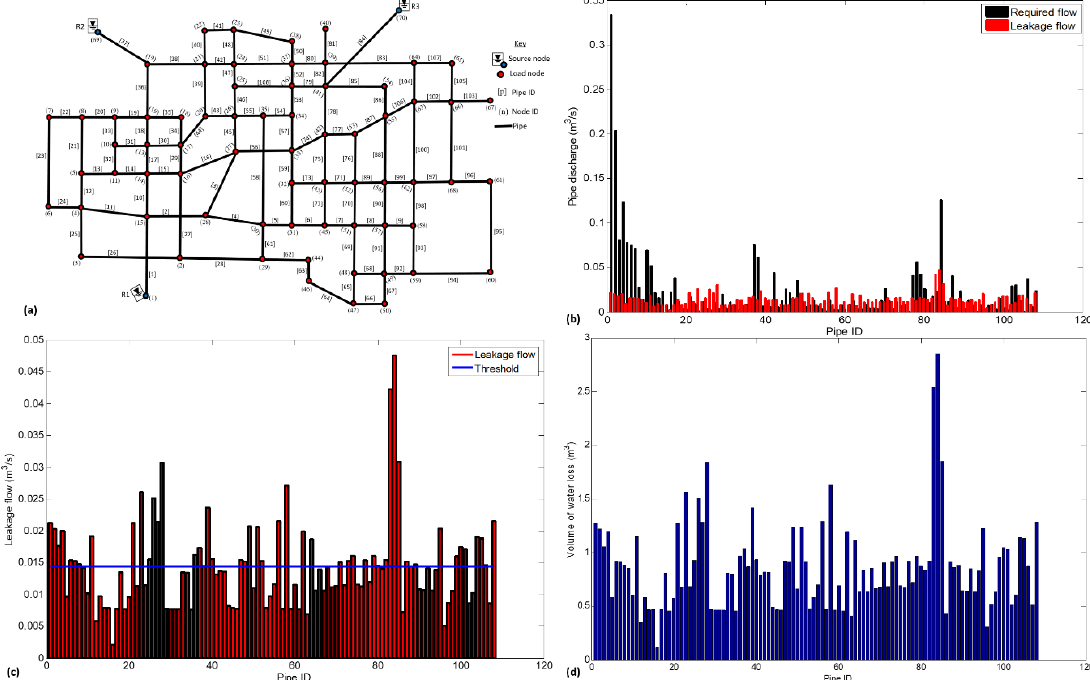
Figure 3. Results of the water network analysis: ( a ) The case study network; ( b ) Pipe discharge vs. pipe leakage flow; ( c ) The pipe leakage flow against the leakage threshold; ( d ) Volume of water loss in each pipe.